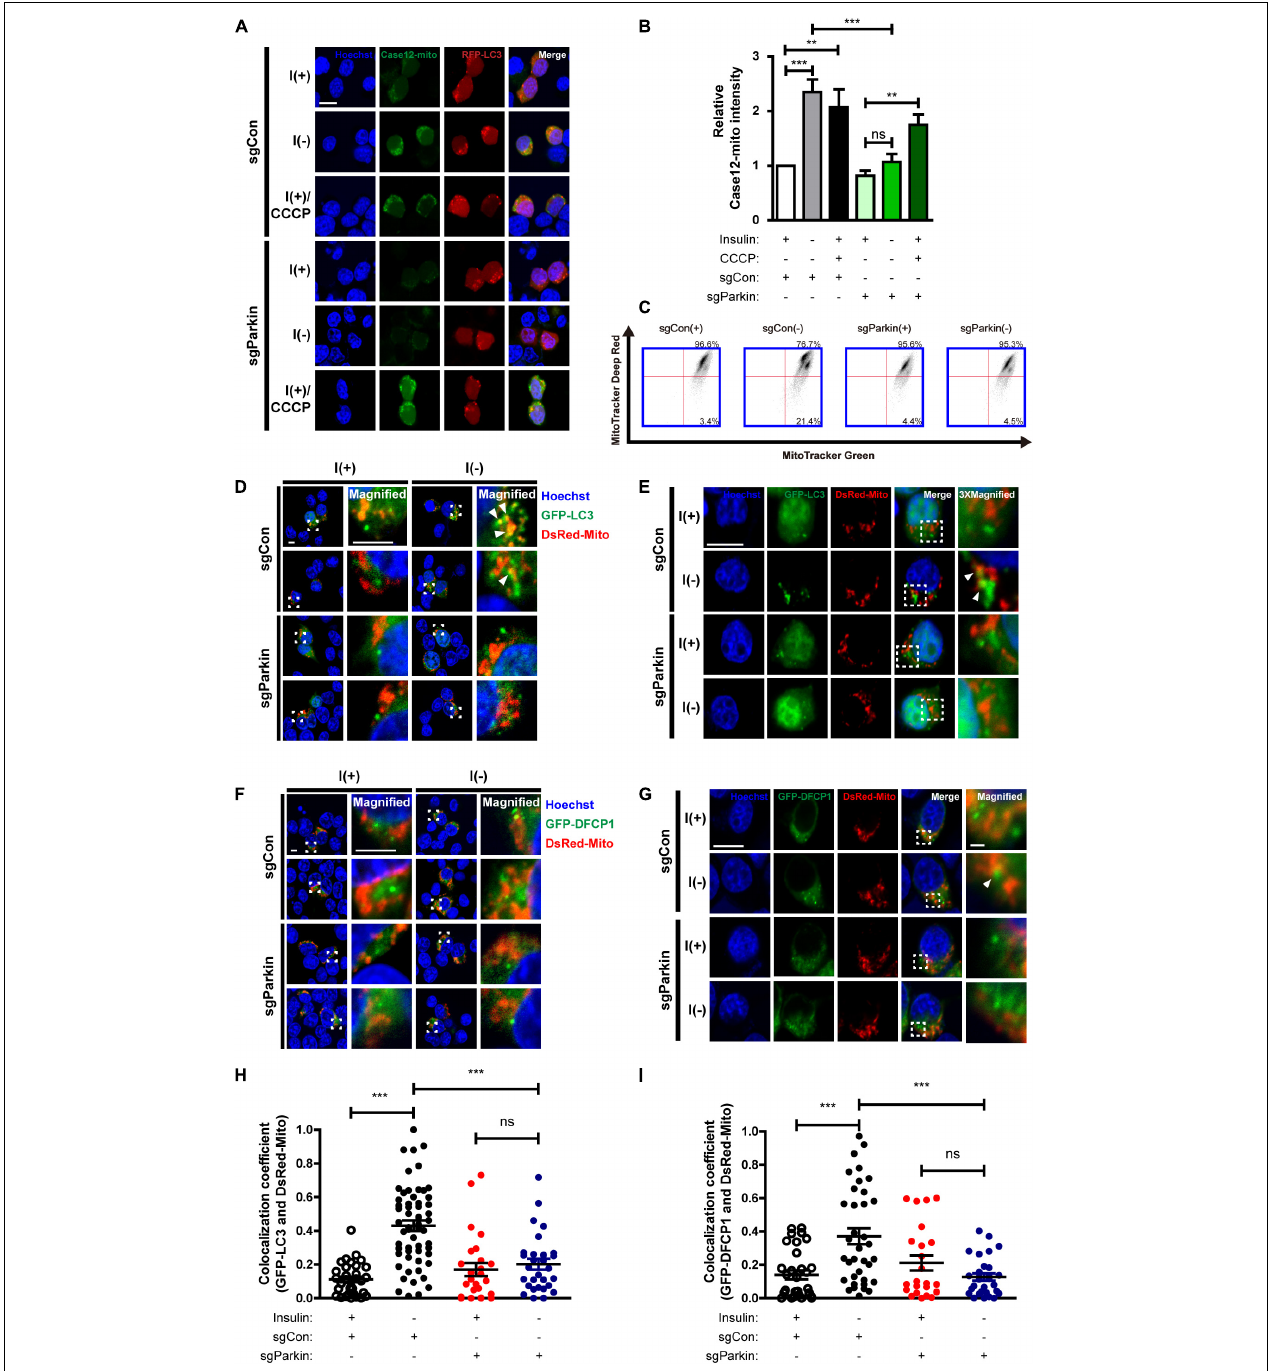
FIGURE 8 | Parkin KO prevents initiation of mitophagy following insulin withdrawal. (A) Fluorescence images of Case12-mito in sgParkin cells after insulin withdrawal for 24 h. Scale bar, 5 µ m. (B) Quantification of fluorescence intensity of Case12-mito ( n = 39 cells for sgCon( + ), 28 cells for sgCon(-), 36 cells for sgCon( + )/CCCP, 80 cells for sgParkin( + ), 73 cells for sgParkin(-), 37 cells for sgParkin( + )/CCCP from 3 independent experiments). (C) Double staining with MitoTracker Green and MitoTracker Deep Red to measure the ratio of depolarized mitochondria relative to total mitochondria after insulin withdrawal for 24 h. (D,E) Colocalization of LC3 and mitochondria in sgParkin cells after co-transfection with GFP-LC3 and DsRed-Mito. Colocalization was analyzed after insulin withdrawal for 24 h. Arrowheads indicate colocalization of GFP-LC3 and DsRed-Mito. Scale bars, 5 µ m for (D) , 10 µ m for (E) . (F,G) Colocalization of DFCP1 and mitochondria (arrowheads) in sgParkin cells after insulin withdrawal for 24 h. Scale bars, 5 µ m for (F) , 10 µ m for (G) . (H) Quantification of colocalization of LC3 and mitochondria ( n = 26–52 cells from 3 independent experiments). (I) Quantitative analysis of colocalization of DFCP1 and mitochondria ( n = 23–36 cells from 3 independent experiments). ∗∗ p < 0.01, ∗∗∗ p < 0.001; ns, not